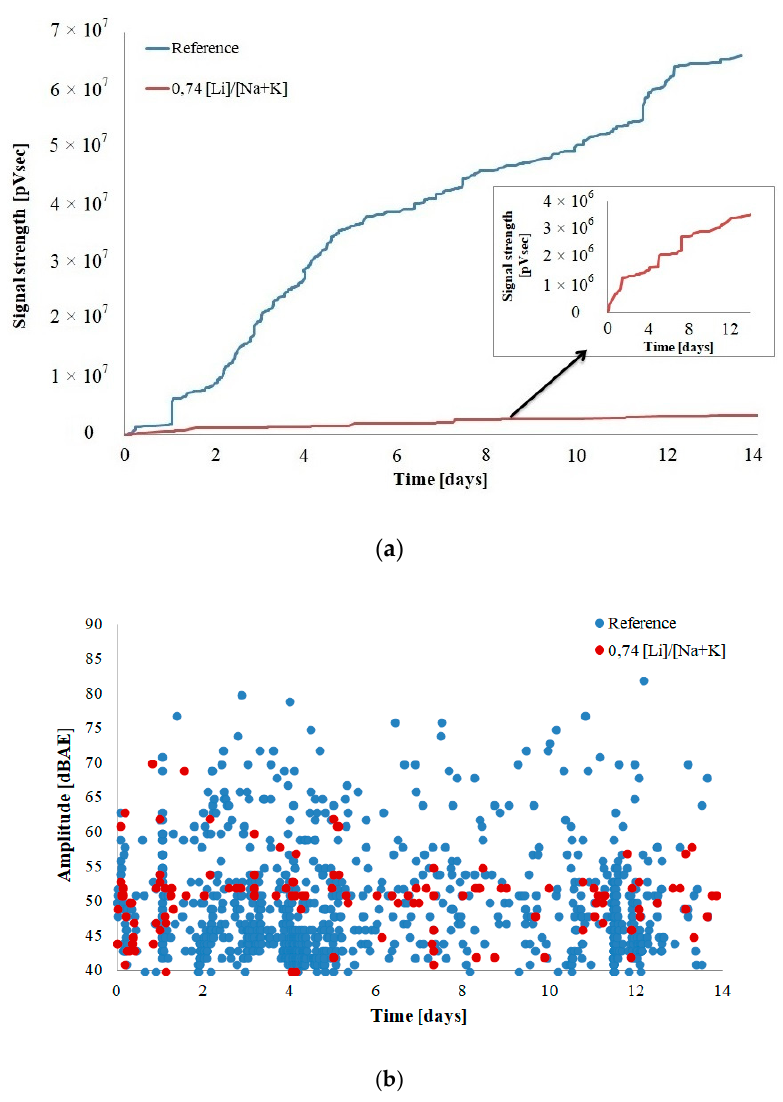
Figure 4. AE characteristics of mortar bars ( a ) signal strength and ( b ) amplitude.